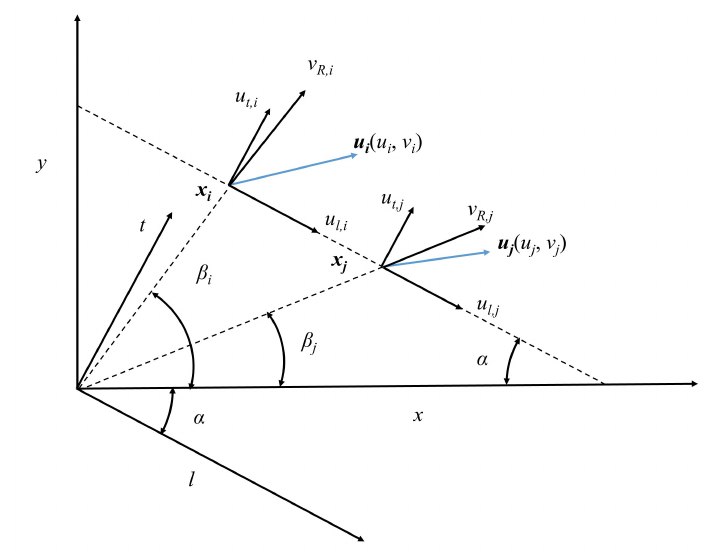
Figure A2. Decomposition of velocities at two points x i and x j